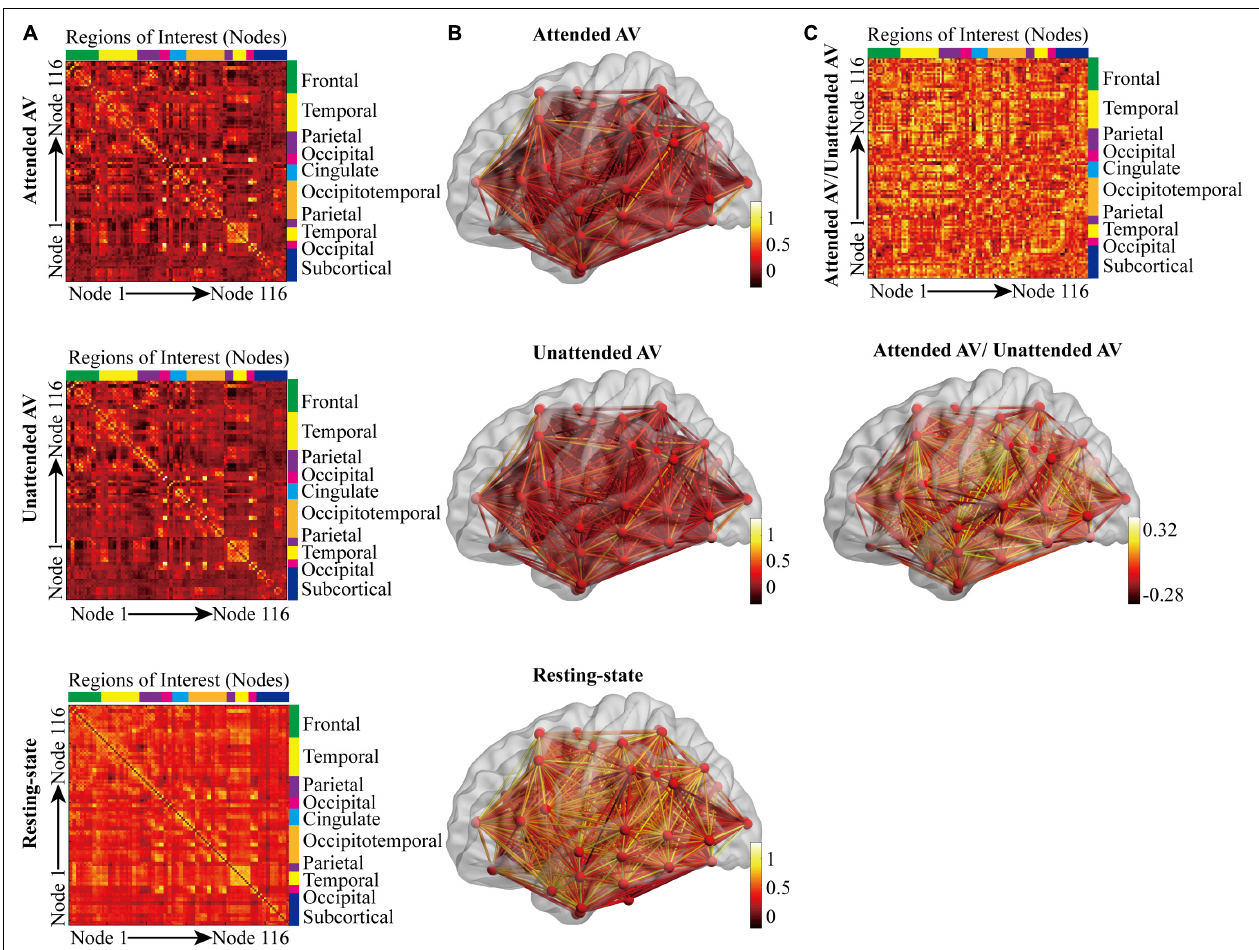
FIGURE 4 | Correlation matrices and connectivity patterns of the functional brain networks in three conditions. (A) The correlation matrices calculated based on 116 regions in the anatomical automatic labeling (AAL) template, corresponding to the attended AV, unattended AV, and resting-state conditions. (B) The subject-averaged functional connectivity patterns in the brain plotted for the attended AV, unattended AV, and resting-state conditions. The color bar indicates the functional connection strength. (C) Differences between subject-averaged connectivity patterns plotted for the attended AV minus the unattended AV condition. Brighter colors depict stronger connections for the attended AV than for the unattended AV condition, whereas darker colors indicate that the unattended AV connections are stronger than the attended connections.